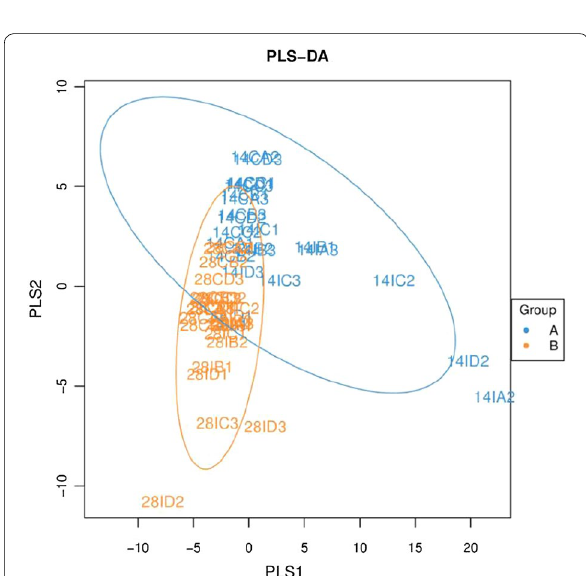
Fig. 4 Partial least squares discriminant analysis (PLS‑DA) of ileal and cecal microbiota among groups. a 14‑day sample groups; b 28‑day sample